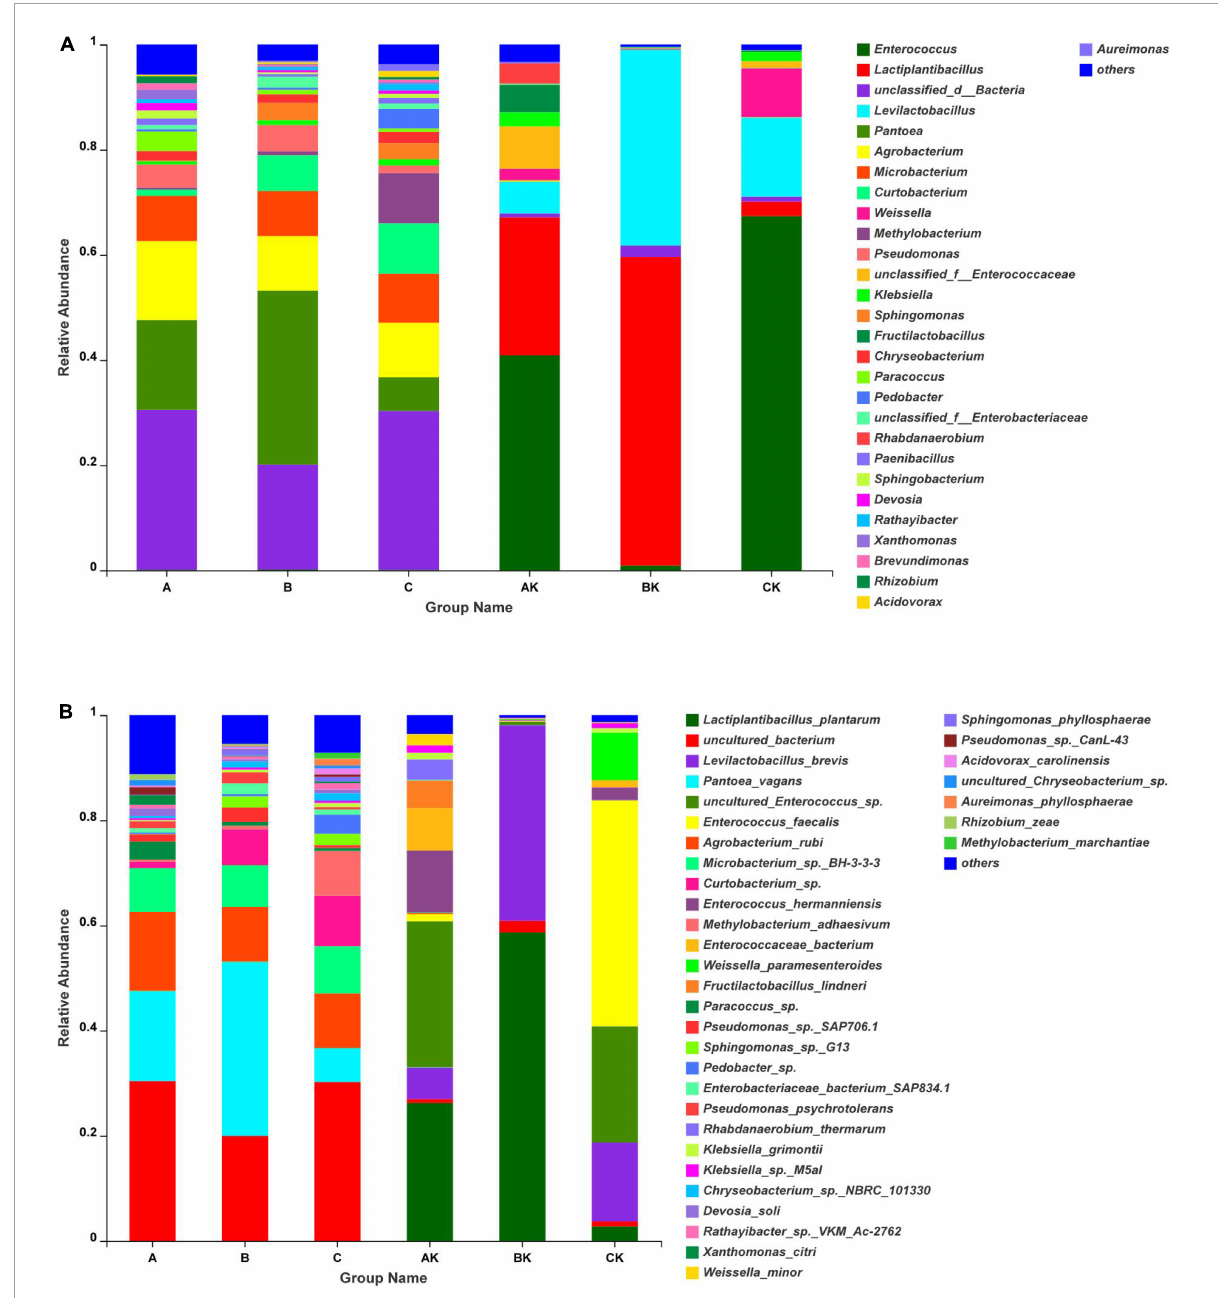
FIGURE2 Bacterial community composition at genus (A) and species (B) levels in fresh ryegrass and ryegrass silage by SMRT. A, first harvest of fresh ryegrass; B, second harvest of fresh ryegrass; C, third harvest of fresh ryegrass; AK, first harvest of ryegrass silage; BK, second harvest of ryegrass silage; CK, third harvest of ryegrass